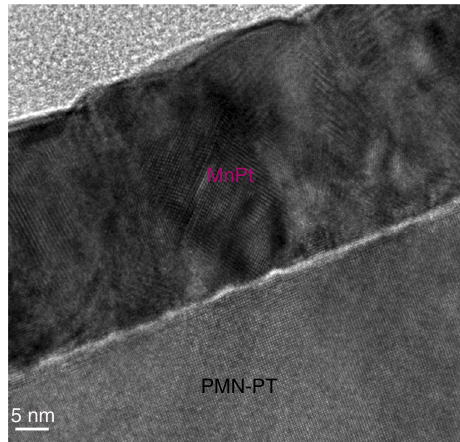
Fig. 1 Structural characterization. Cross-section transmission electron microscopy of a 35-nm-thick MnPt/PMN-PT heterostructure. The scale bar on the left bottom corresponds to 5